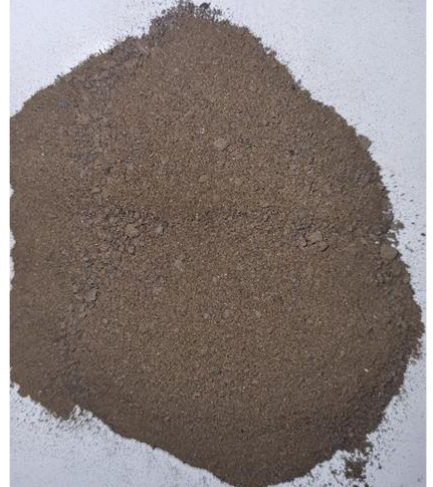
Figure 4. Photo of the slag used in the research.